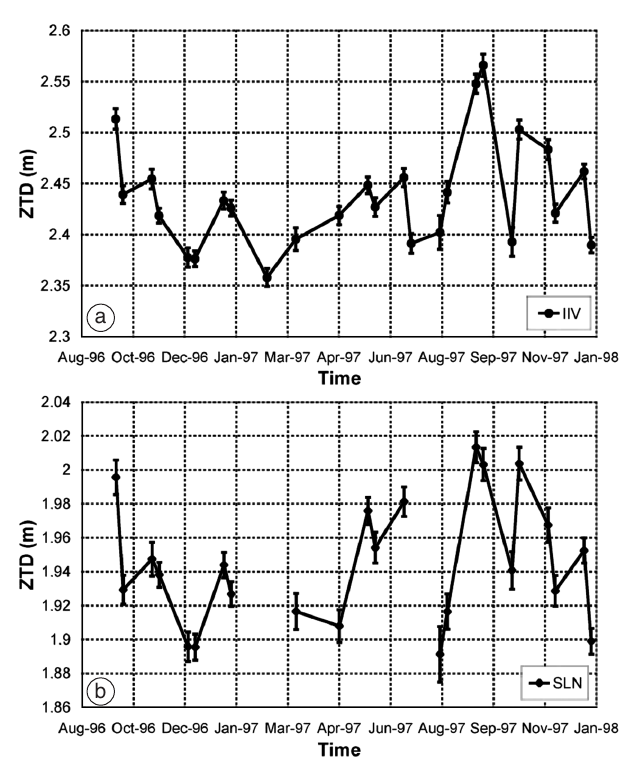
Fig. 3a,b. a) ZTD values corresponding to IIV site for each session, at the time of ERS-2 passes over Mt. Et- na. b) ZTD values corresponding to SLN site for each session, at the time of ERS-2 passes. The error bars are the formal errors obtained by the analysis performed with GAMIT software.